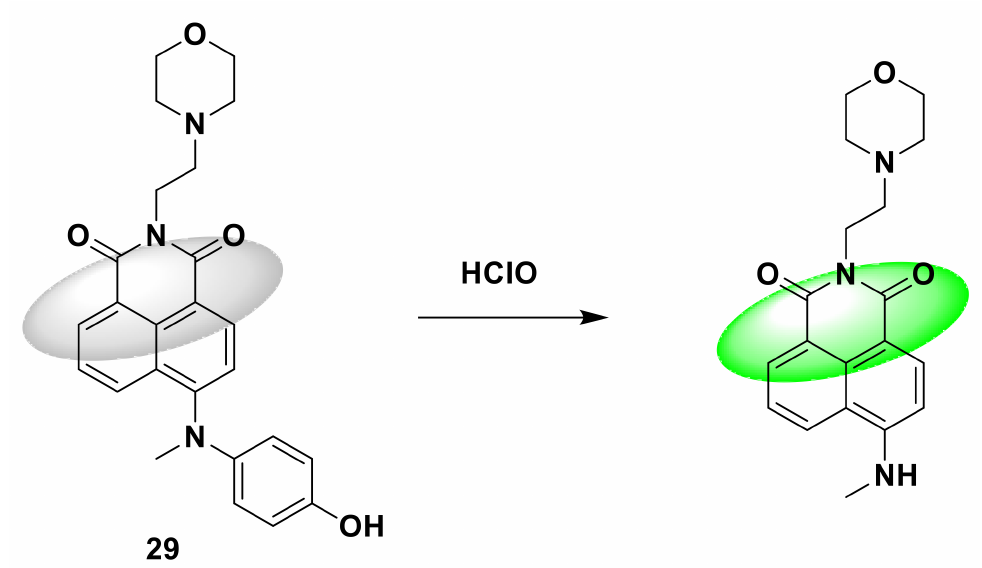
Figure 29. The reaction of probe 29 and HClO.